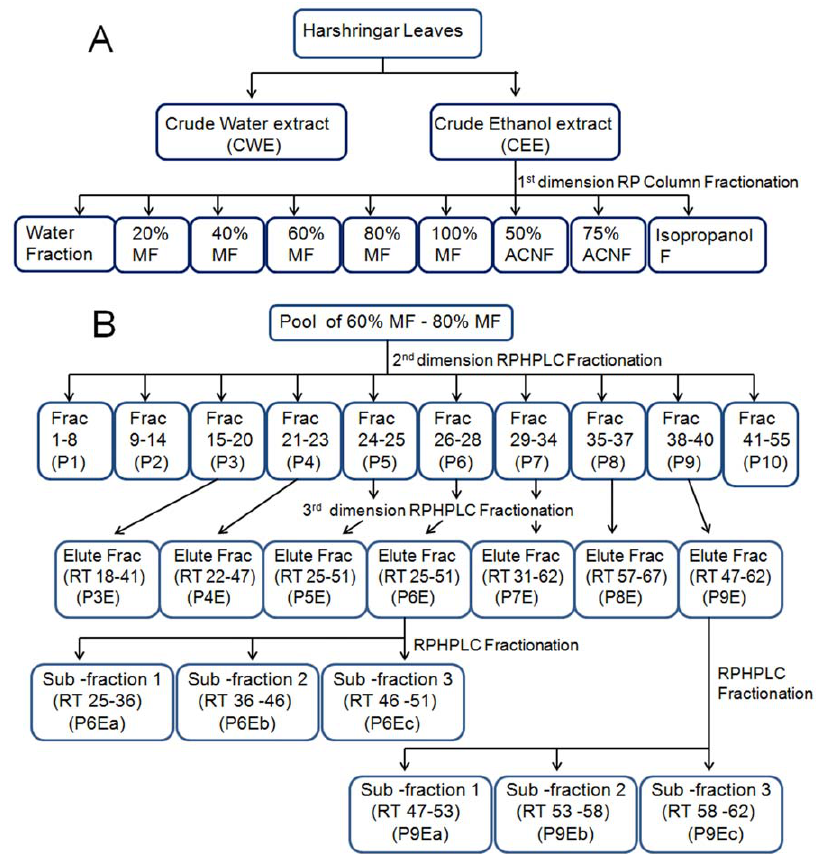
Figure 1. Scheme of extraction and reverse-phase fractionation of Nyctanthesarbor-tristis (Harshringar) leaves. Panel A shows scheme of solvent extractions and 1 st dimension reverse phase (C 18 ) fractionation of ethanolic extract of leaves. MF (Methanol Fraction), ACNF (Acetonotrile Fraction). Panel B shows 2 nd and 3 rd dimension RPHPLC fractionation of 60% –80% MF. RT (Retention time in minutes).